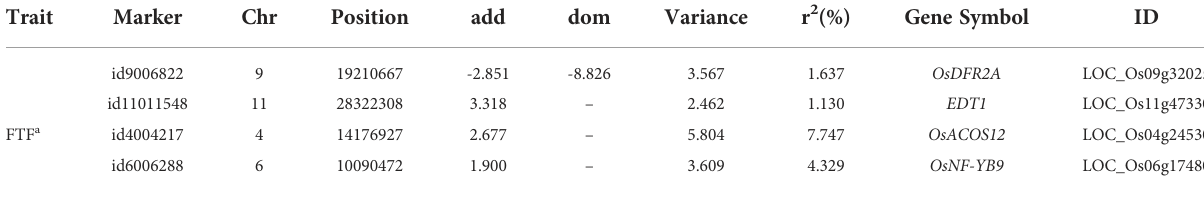
(Table 3; Supplementary Figure S2A) and 1 QEI (Table 4; Supplementary Figure S2B) overlapped with the known genes.